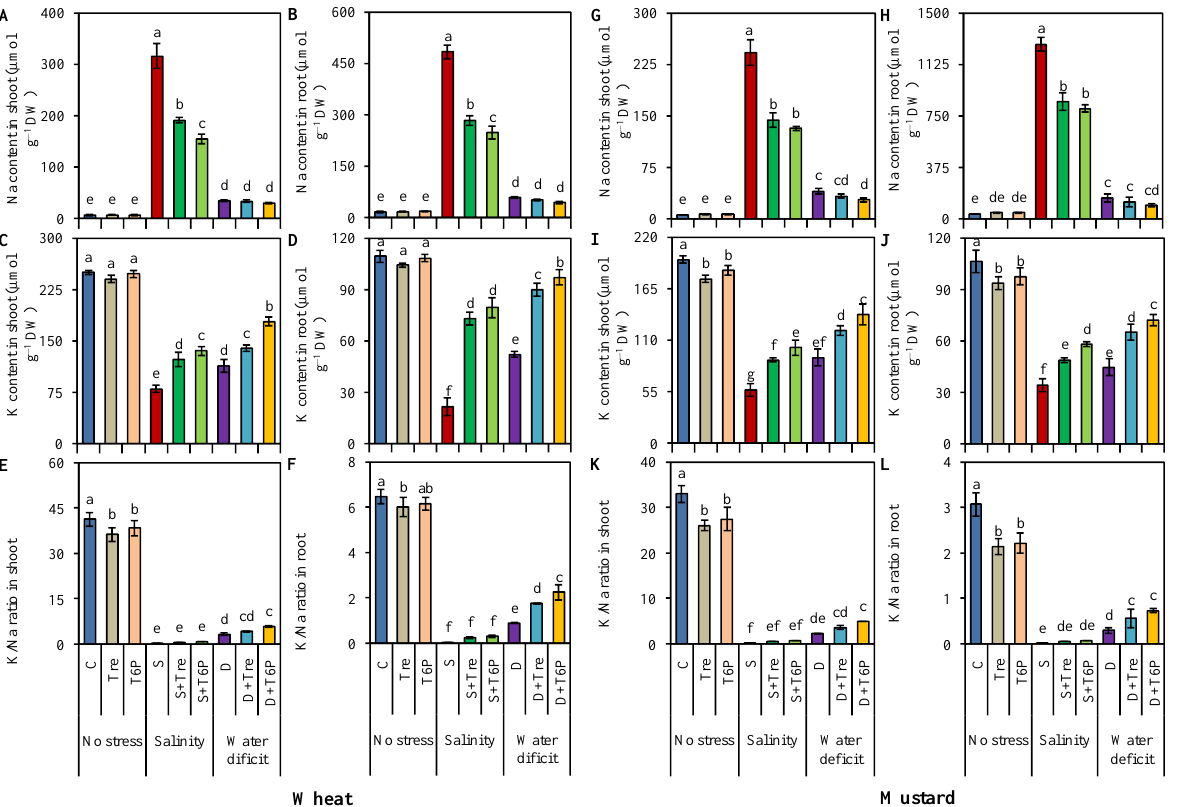
Figure 7. Effect of trehalose and T6P on the contents of Na and K and the K/Na ratio in shoots and roots of wheat and mustard seedlings. Wheat seedlings were grown in a hydroponic solution containing 300 mM NaCl for 9 days. Mustard seedlings were grown in 200 mM NaCl for 10 days. For water deficit treatment, wheat seedlings were treated with 20% PEG, while mustard was treated with 12% PEG for four days. C, control; ( A – F ) wheat; ( G – L ) mustard; Tre, 200 µM trehalose; T6P, 200 µM trehalose 6-phosphate; S, NaCl treatment; D, water deficit treatment with PEG 6000. Means were calculated from three replicates for each treatment, and the bars represent the standard deviation (±SD). Values with different letters are significantly different at p ≤ 0.05 by Fisher’s LSD test. In mustard seedlings, Na content increased in the shoots (by 3982 and 578%, respec- tively) and roots (by 3566 and 338%, respectively) under salinity and water deficit stress compared to control. The content of K in both shoots and roots was reduced under salt and water deficit stresses; therefore, the K/Na ratio was reduced in shoots by 99 and 93%, respectively, and in roots by 99 and 90%, respectively, compared to control seedlings. Seedlings pretreated with Tre and T6P contained reduced shoot and root Na contents but increased the shoot and root K contents and K/Na ratio under both salt and water deficit stresses, compared with stressed seedlings only (Figure 7G–L). Salinity and water deficit stresses decreased the content of Ca in shoots (by 50 and 37%, respectively), Ca in roots (by 82 and 73%, respectively), Mg in shoots (by 61 and 56%, respectively), and Mg in roots (by 67 and 57%, respectively) in mustard seedlings compared to unstressed control seedlings. However, seedlings pretreated with Tre and T6P showed increased Ca and Mg contents in both shoots and roots under stressed conditions compared to water deficit-stressed seedlings only (Figure